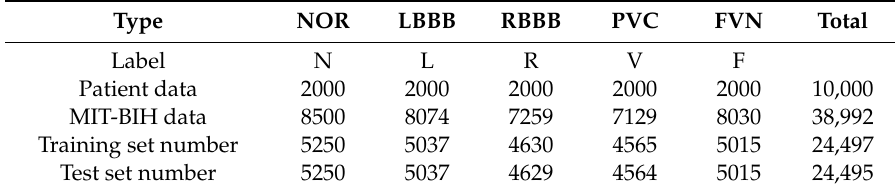
Table 5. Number of ECG beats per class used in the experiment.